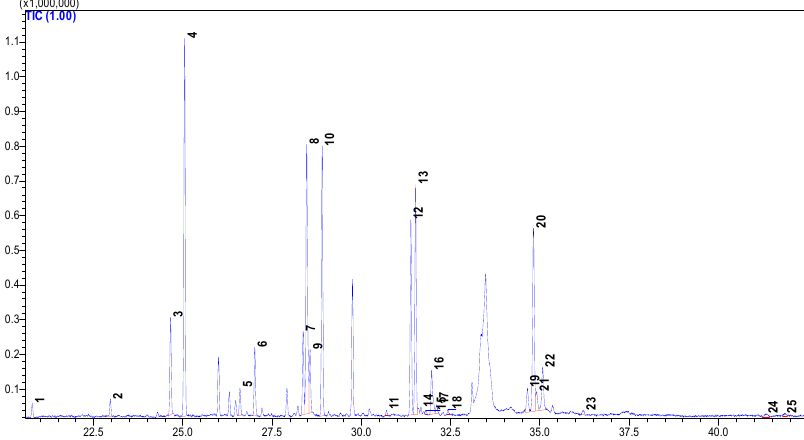
Figure A1. The representative GC-MS total ion chromatogram (TIC) profiles of fatty acid methyl esters (FAMEs) from black tiger shrimp (edible flesh). 1. C14:0 (Myristic), 2. C15:0 (Pentadecanoic), 3. C16:1n7c (cis-9; Palmitoleic), 4. C16:0 (Palmitic), 5. C17:1 (cis-10-Heptadecenoic), 6. C17:0